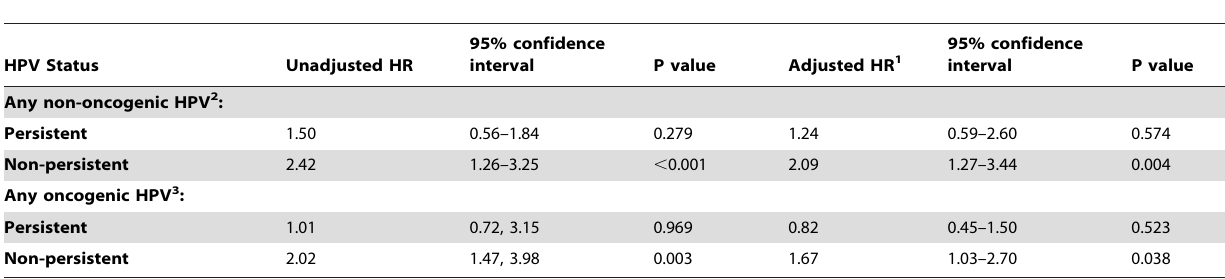
Table 3. Persistent and non-persistent HPV infection as predictors of HIV acquisition.